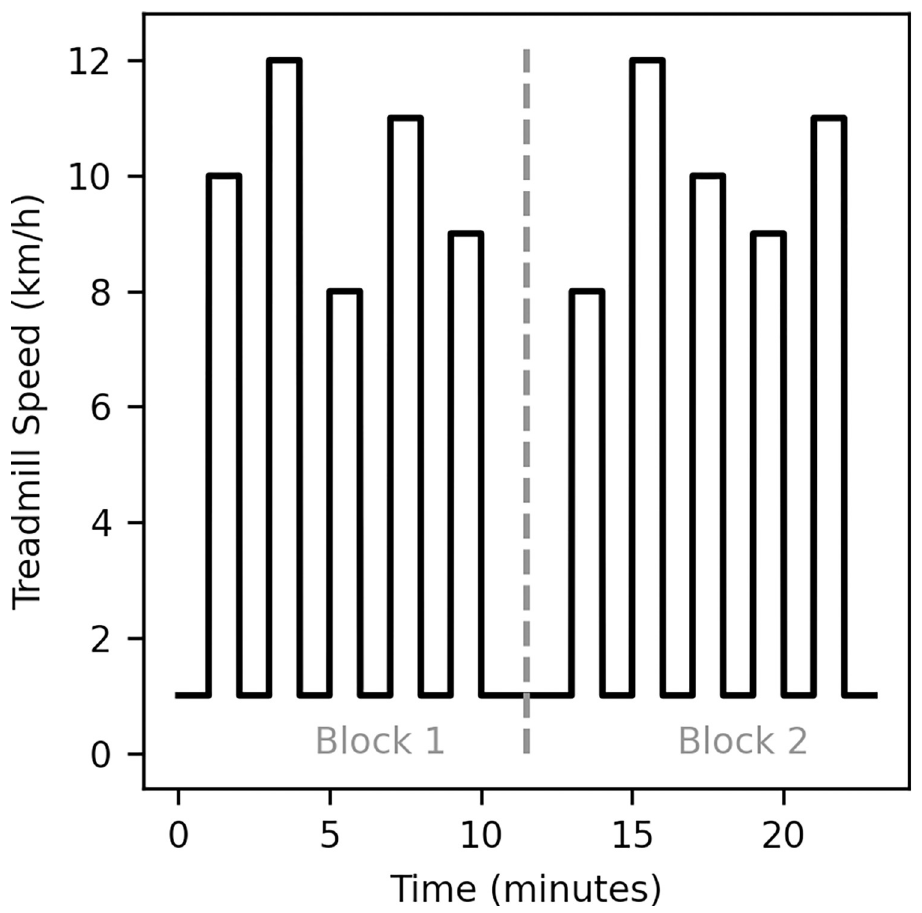
Fig 2. Running intervals. An example of the running interval profile for a participant with a preferred running speed range of 8–12 km/h. Participants ran for one minute at each selected speed with a one-minute break (walking at 1 km/ h) between each running interval. This was completed twice (Block 1 & 2) with the speed order randomised within each block and a three-minute walking period between the